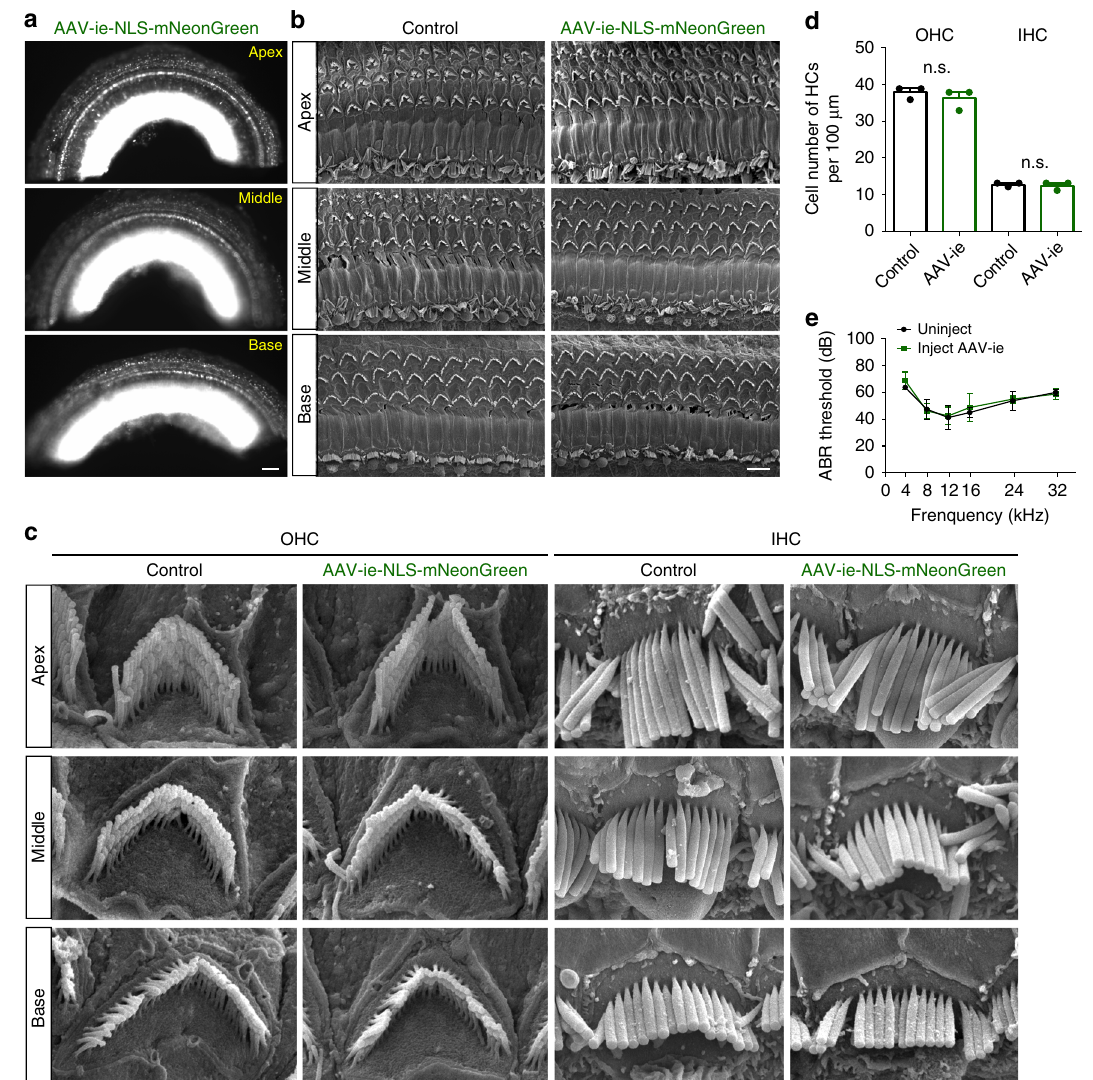
Fig. 4 Adeno-associated virus-inner ear (AAV-ie) has a minimal adverse effect on auditory in injected mice. a Representative epi- fl uorescence image of P30 AAV-ie-NLS-mNeonGreen (nuclear localization sequence-mNeonGreen)-injected cochlea. The mice were injected at P3 at a dose of 1 × 10 10 genome- containing (particles) (GCs) per ear. Scale bar, 100 µ m. b Scanning electron microscopy (SEM) images of P30 control and AAV-ie-NLS-mNeonGreen- injected cochlea at apical, middle, and basal regions. Scale bar, 5 µ m. c Magni fi cation SEM images of outer hair cell (OHCs) and inner hair cells (IHCs) of P30 control and AAV-ie-NLS-mNeonGreen-injected cochlea at apical, middle, and basal regions. Scale bar, 1 µ m. d OHCs and IHCs numbers per 100 µ m of P30 control and AAV-ie-NLS-mNeonGreen-injected cochlea. N = 3 mice. p Value is calculated by Student ’ s t test. n.s. refers to no signi fi cance. Source data are provided as a Source Data fi le. e Auditory brain-stem response (ABR) thresholds from AAV-ie-NLS-mNeonGreen-injected and -uninjected ears on day 26 after surgery at P3. Error bars ± SEM. N = 4 mice, respectively. Source data are provided as a Source Data fi